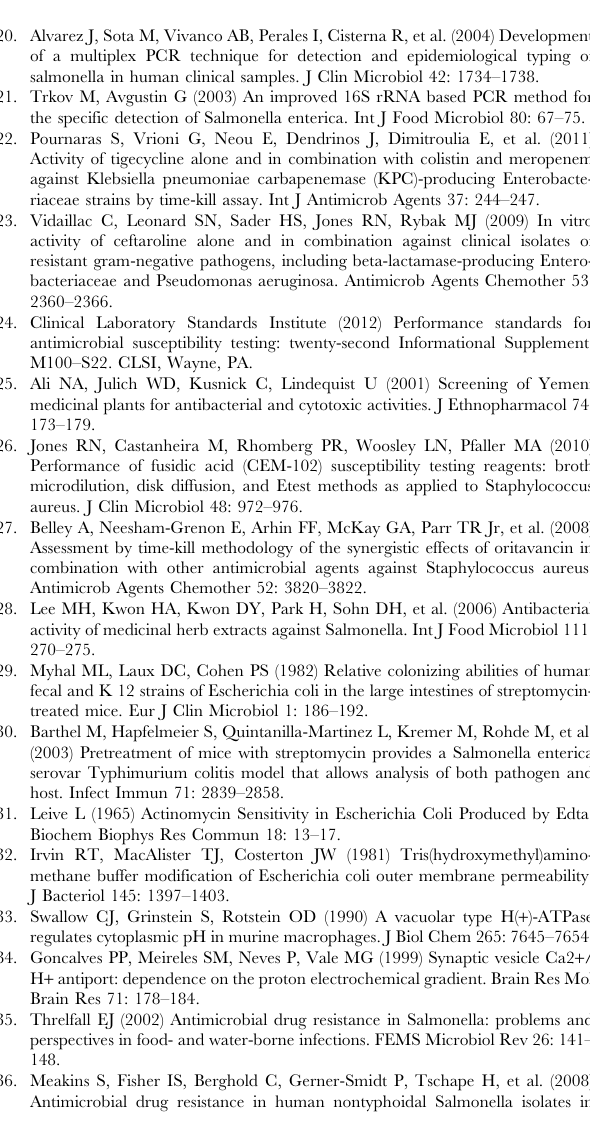
Figure S1 The effects of membrane-permeabilizing agent and ATPase-inhibitor agent on Salmonella (WS-5) susceptibility to MG. The viability of bacteria was determined by a spectrophotometer (optical density at 600 nm, OD 600 ) after incubation for 24 h with 1/2 MIC MG and the indicated concentration of Tris, TX, NaN 3 and DCCD in WS-5 the data are Mean 6 S.D. for triple-independent experiments. A(Tris), B (TX), C(NaN 3 ), D(DCCD). (TIF) Table S1 List of Salmonella strains used in this study and growth inhibition zones produced by